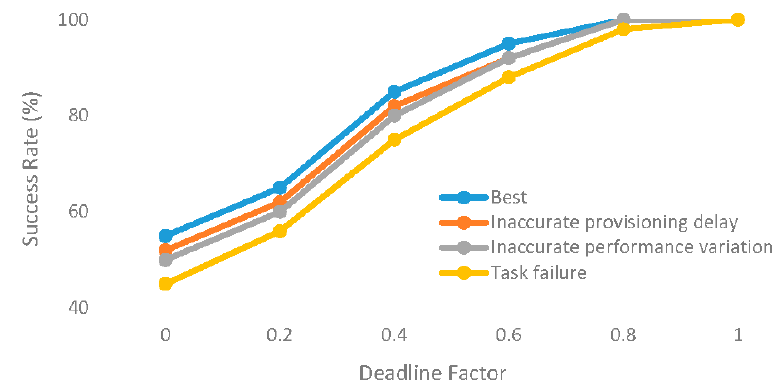
Figure 10. Sensitivity to inaccurate estimations and task execution failure.